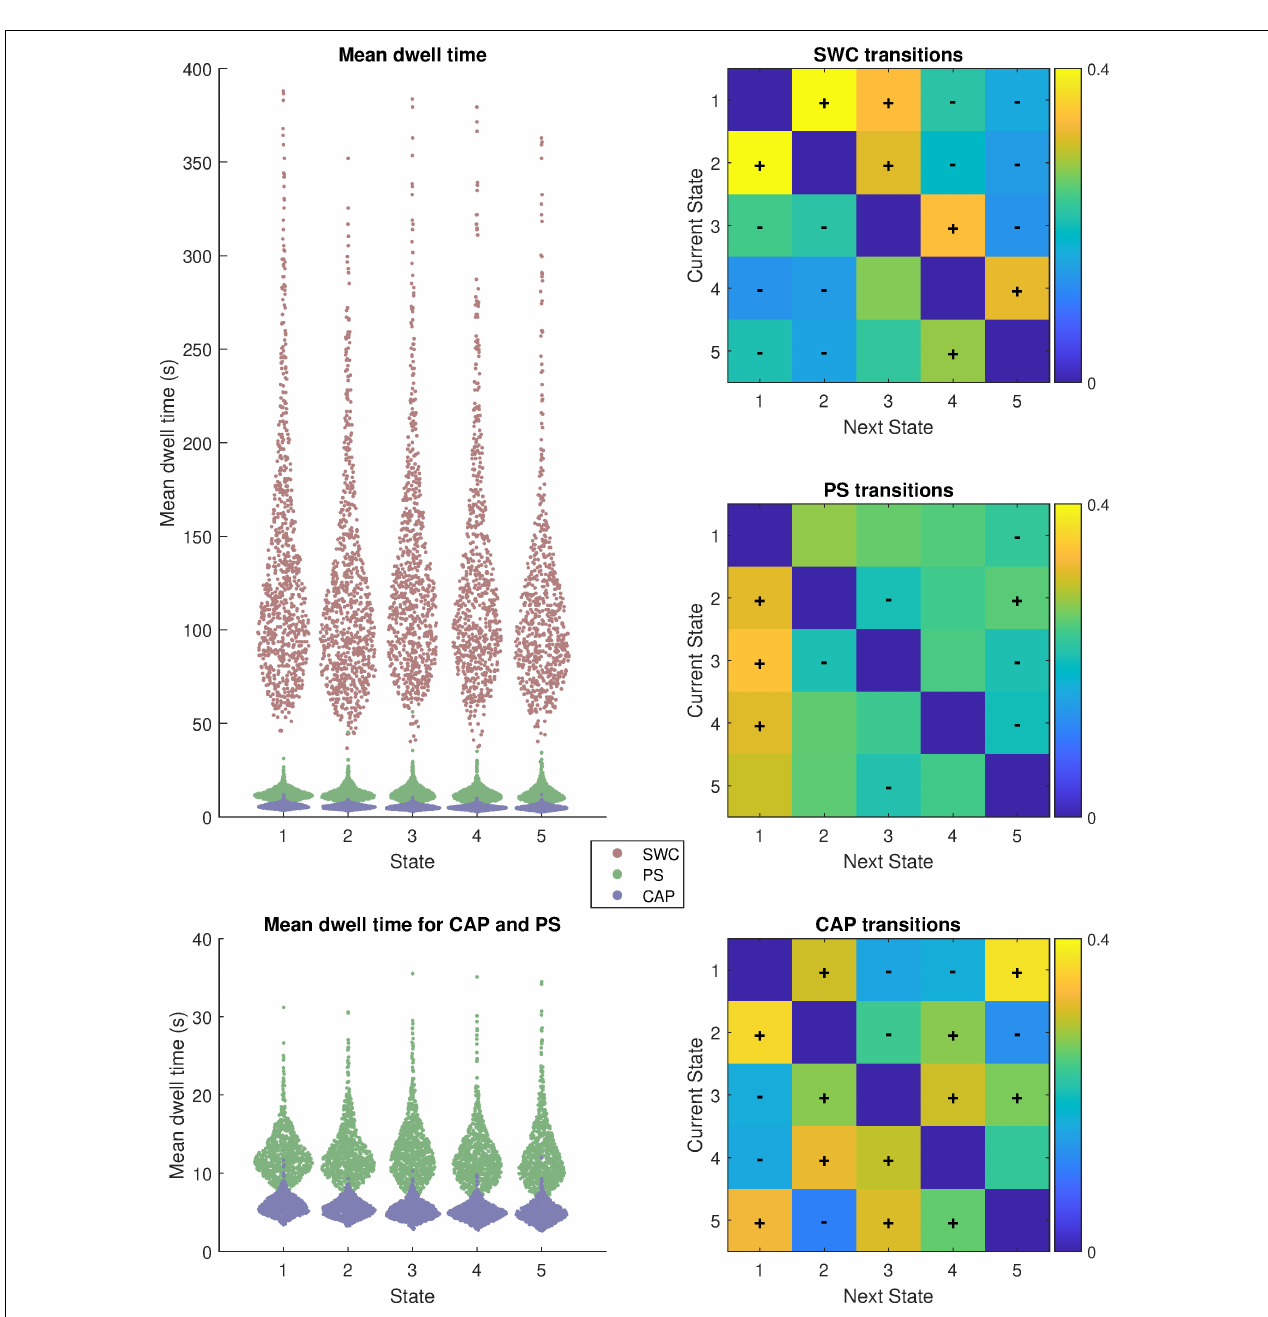
FIGURE 2 | Summary of dynamics metrics; Distribution of mean dwell time between state transitions for each state in each subject ( N = 817) and transition probability matrices from each state to the next. Mean dwell time is displayed with and without SWC included. The “ + ” and “ − ” symbols overlaid on the transition probability matrices indicate transitions that are more or less likely, respectively, than chance to occur based on permutation tests ( p < 0.05; Bonferroni corrected for multiple comparisons).